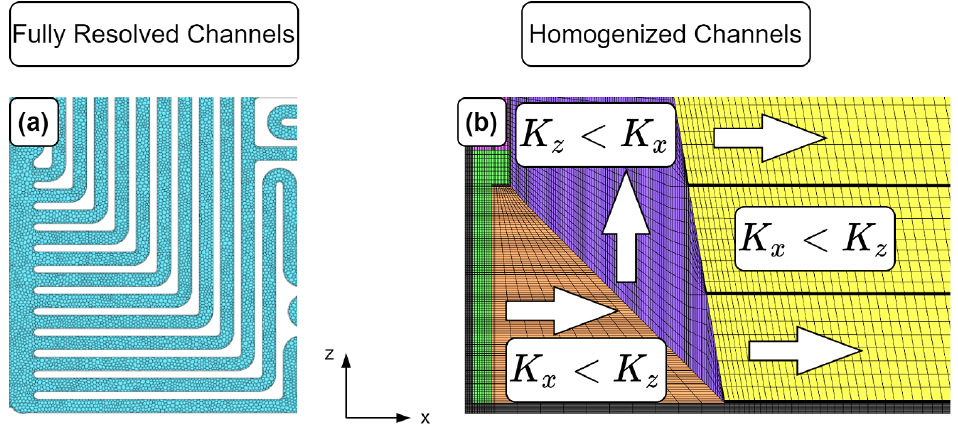
Figure 3. ( a ) Fully resolved channels. ( b ) Homogenized channels with flow steering sections. Green: isotropic permeability; orange and yellow: flow steering in x -direction; purple: flow steering in z -direction; black: computational cells belonging to bipolar plate (solid).